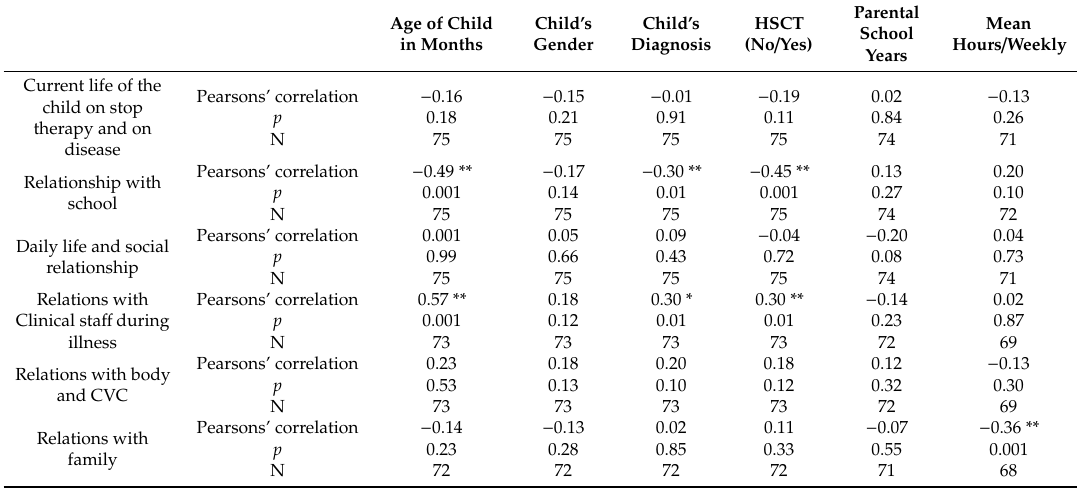
Table 5. Correlation matrix between the codebook size and patient’s socio-demographic